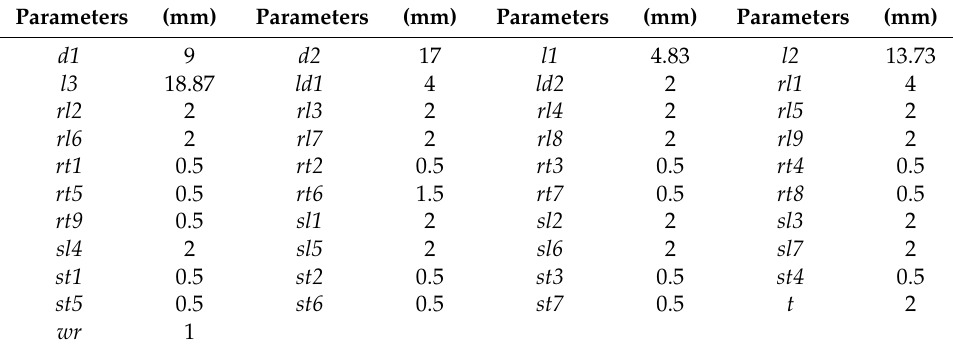
Table 1. Geometries of the horn.